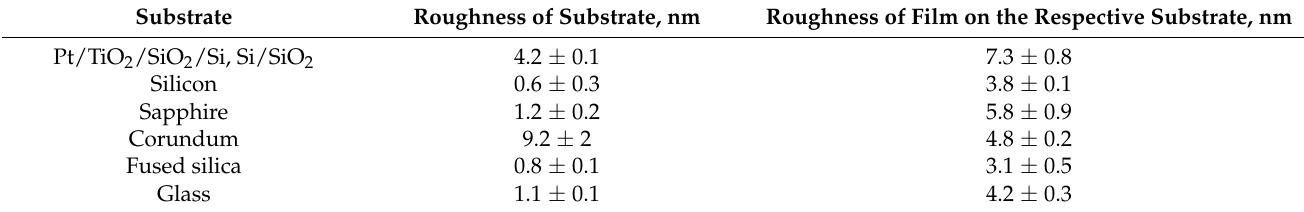
Table 1. Roughness of selected substrates and films calculated as